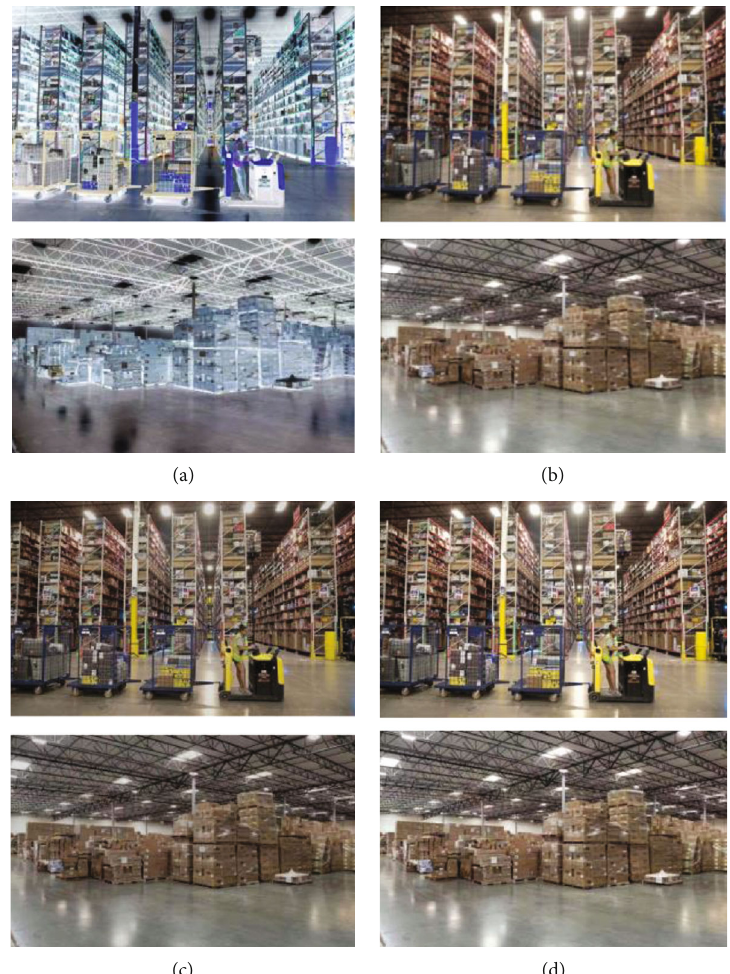
Figure 4: Experimental results of di ff erent image enhancement algorithms: (a) original image; (b) gradient domain image enhancement algorithm processing; (c) image contrast enhancement algorithm processing based on gradient fi eld equalization; (d) partial di ff erential enhancement based on histogram equalization algorithm